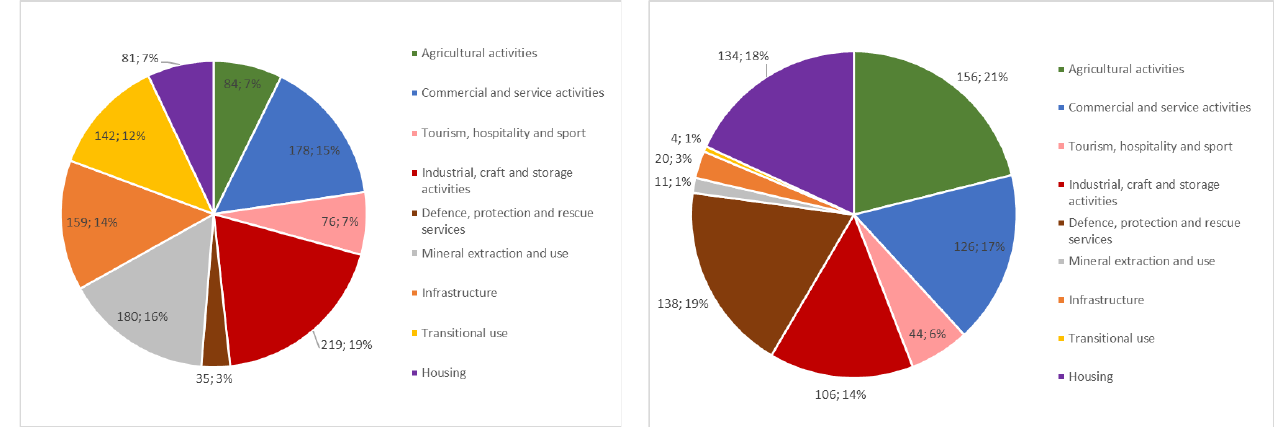
Figure 3. Brownfield structure in 2022 for Slovenia ( left ) and the Moravian-Silesian region ( right ) (by type). Based on [25,27]. Prepared by the authors.